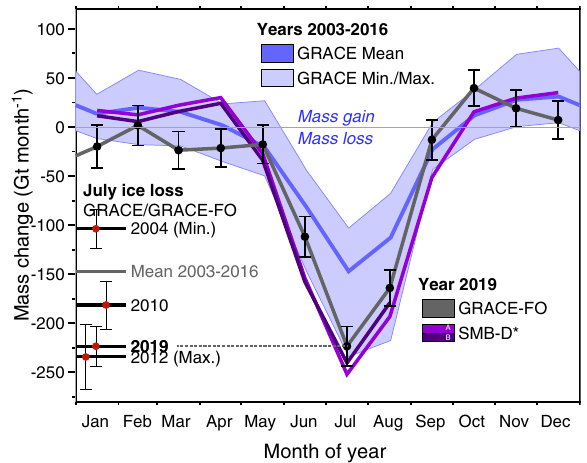
Fig. 3 Monthly mass change of the Greenland Ice Sheet for the year 2019 and average rates for the years 2003 to 2016. Shown are monthly mass changes for GRACE-FO (black, with 2- σ error bars) and SMB-D* (light violet: MARv3.10; dark violet RACMO2.3p2) from January to September 2019, along with the seasonal climatology from GRACE for 2003 – 2016. A positive mass change represents accumulation; a negative mass change indicates ablation. July 2019 ranks as the summer month with the second largest mass loss recorded by GRACE/GRACE-FO (red dots), exceeded only by 2012, and followed by 2010. Because of gaps in the GRACE/ GRACE-FO record of mass change, July mass changes are known for 2004 through 2010, 2012, 2016, and 2019 (13 years in